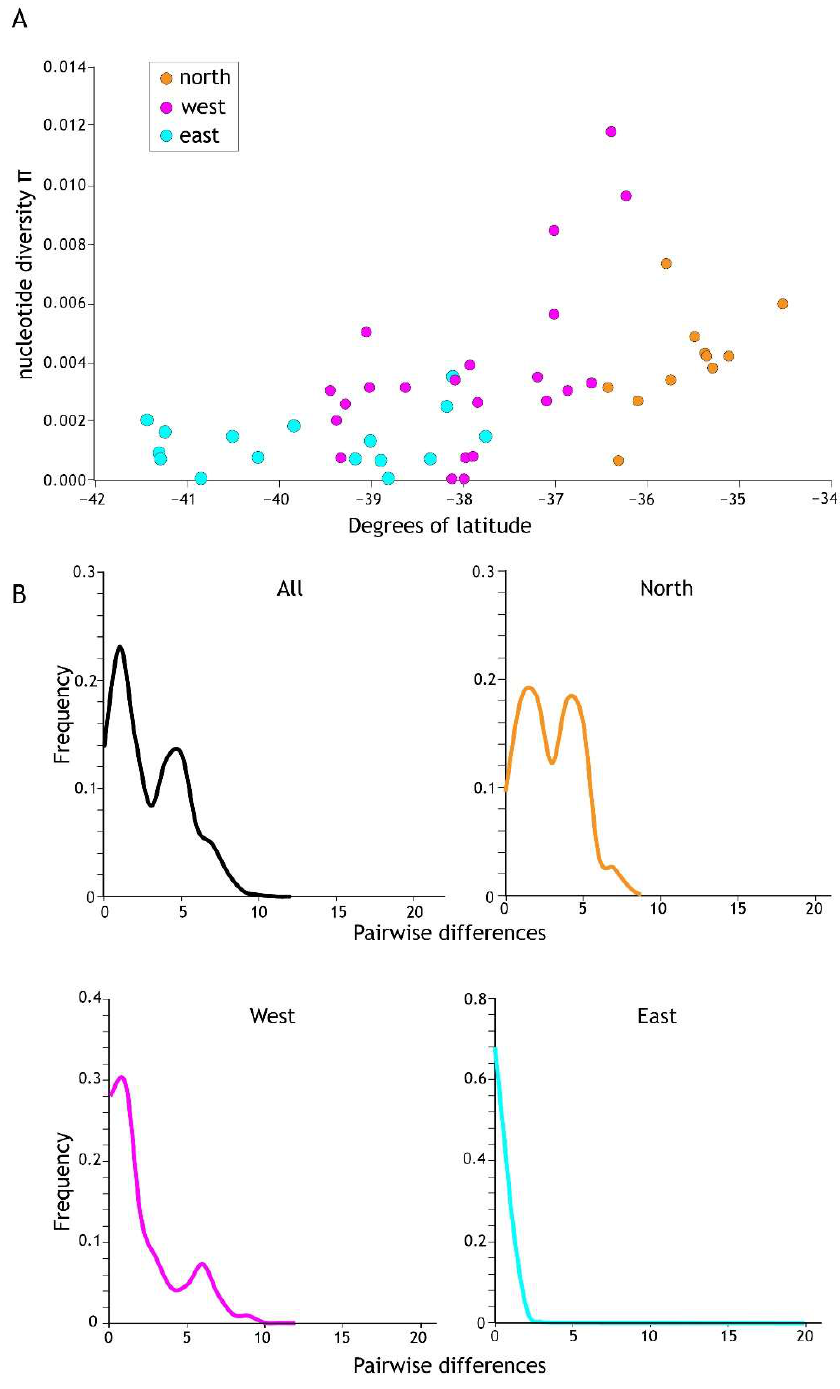
Figure 5. ( A ) Higher levels of genetic diversity (π) per population sample were recorded in the north of the Acanthophlebia cruentata distribution. Population sample nucleotide site diversity (280 bp cytb mtDNA) by latitude with north to the right and south to the left. ( B ) Mismatch distribution of cytb sequence diversity for all and regional subsets (see Figure 4).